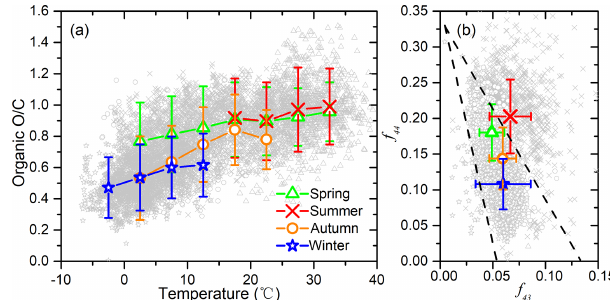
Figure 2. (a) O / C ratio as a function of temperature in different seasons of Beijing; (b) triangle plot ( f 44 vs. f 43 ) measured by the Q-ACSM in different seasons of